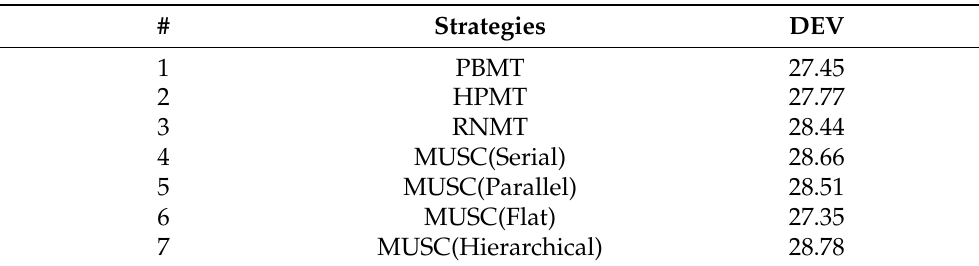
Table 4. Result of different combination strategies for the multi-source-based system combina- tion model.